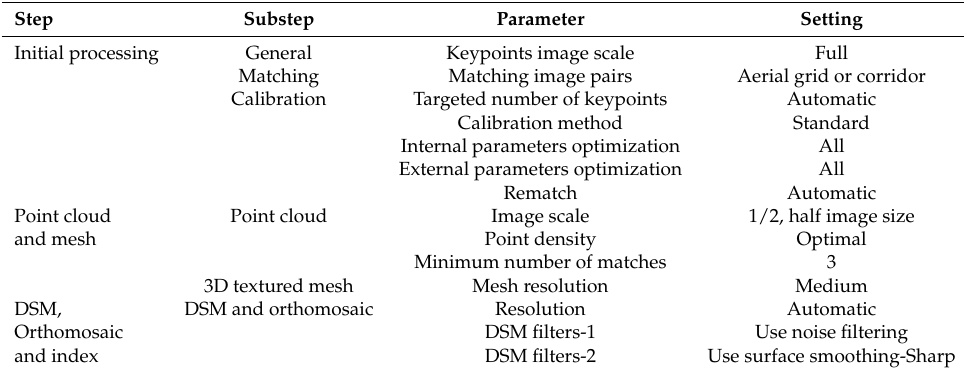
Table A1. Specific steps and parameters of UAS image